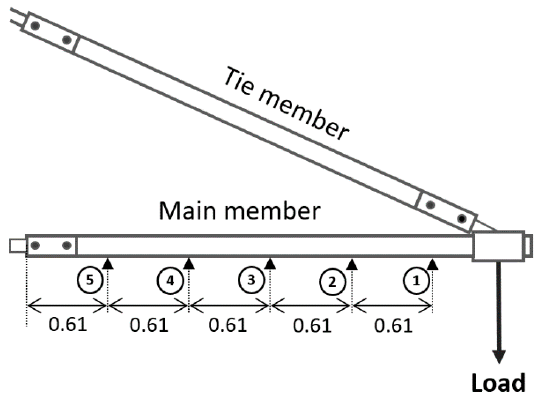
Figure 1. Positions of dial gauges under the cross-arm to measure creep strain pattern, in meter.